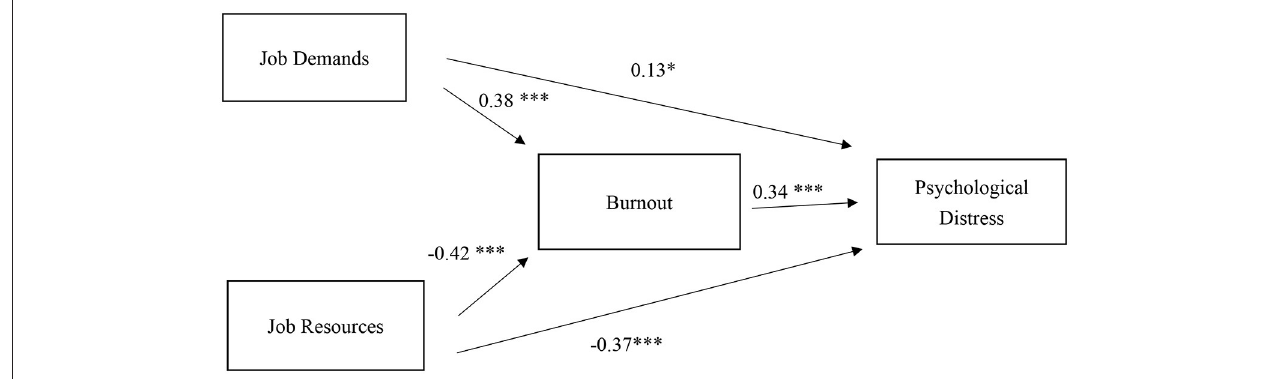
FIGURE 2 | Standardized estimates of JD-R, burnout, and psychological distress model. * p < 0.05,*** p <